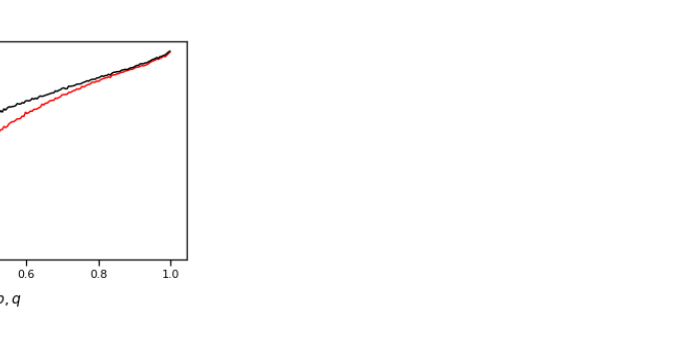
Figure 6. The comparison results of the iteration number of CFA (the parameters are respectively 0.5 and 1.5) and MGA.